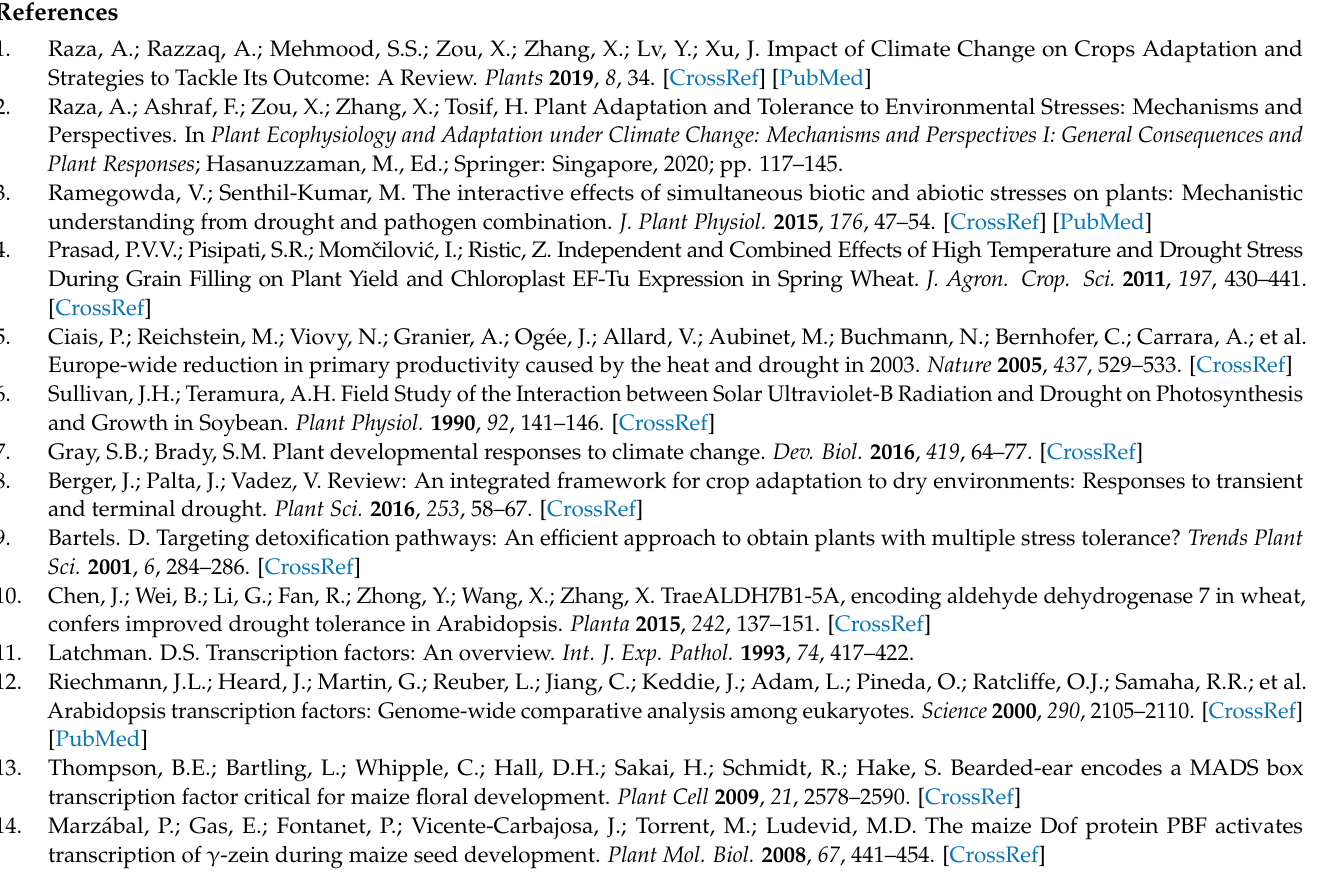
Table S7: Transcript abundance of ZmAP2/ERF genes under stress environment; Supplementary Table S8: Transcript abundance of ZmAP2/ERF genes under JA treatment (OF, Ostrinia furanacalis , Asian corn borer); Supplementary Table S9: Transcript abundance under wounding with or without oral secretions from Mythimna separata ; Supplementary Table S10: Differential expression under ABA, Cold, Heat and drought; Supplementary Table S11: Differential expression under JA treatment and insect feeding; Supplementary Table S12: Differential expression under wounding with or without oral secretions from Mythimna separata; Supplementary Table S13: Primers list of qRT-PCR. Supple- mentary Figure S1: LOGOS of conserved Motif Analysis, Supplementary Figure S2: Chromosomal location of ZmAP2/ERF genes; Supplementary Figure S3: Cis regulatory elements; Supplementary Figure S4: Heat map of AP2/ERF genes in different maize tissues; Supplementary Figure S5: Venn diagram under different abiotic stresses. References from Supplementary Materials: